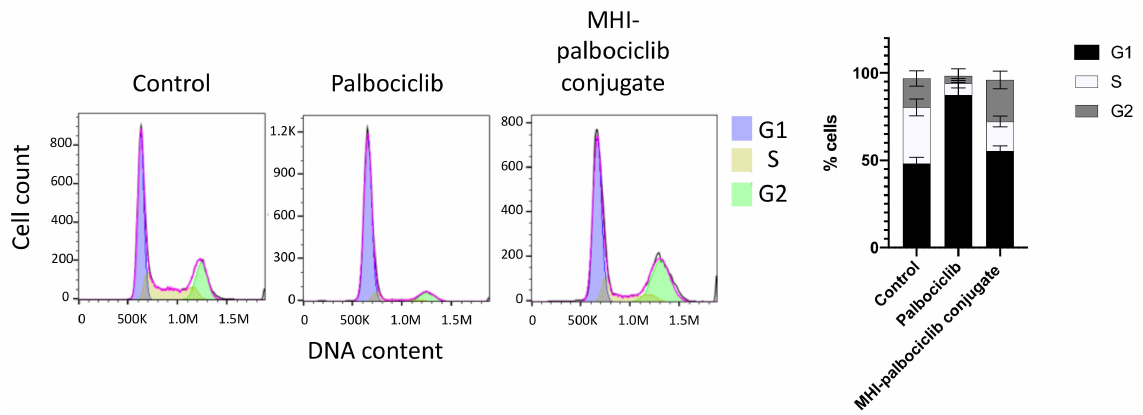
Figure 4. The cell cycle proportions of MDA-MB-231 breast cancer cells after exposure to 500 nM palbociclib or MHI-palbociclib for 24 h, followed by flow cytometry cell cycle analysis. Control: no drugs administered. Representative cell cycle profiles are shown on the left, and the average result of three independent experiments are shown in the bar graph.